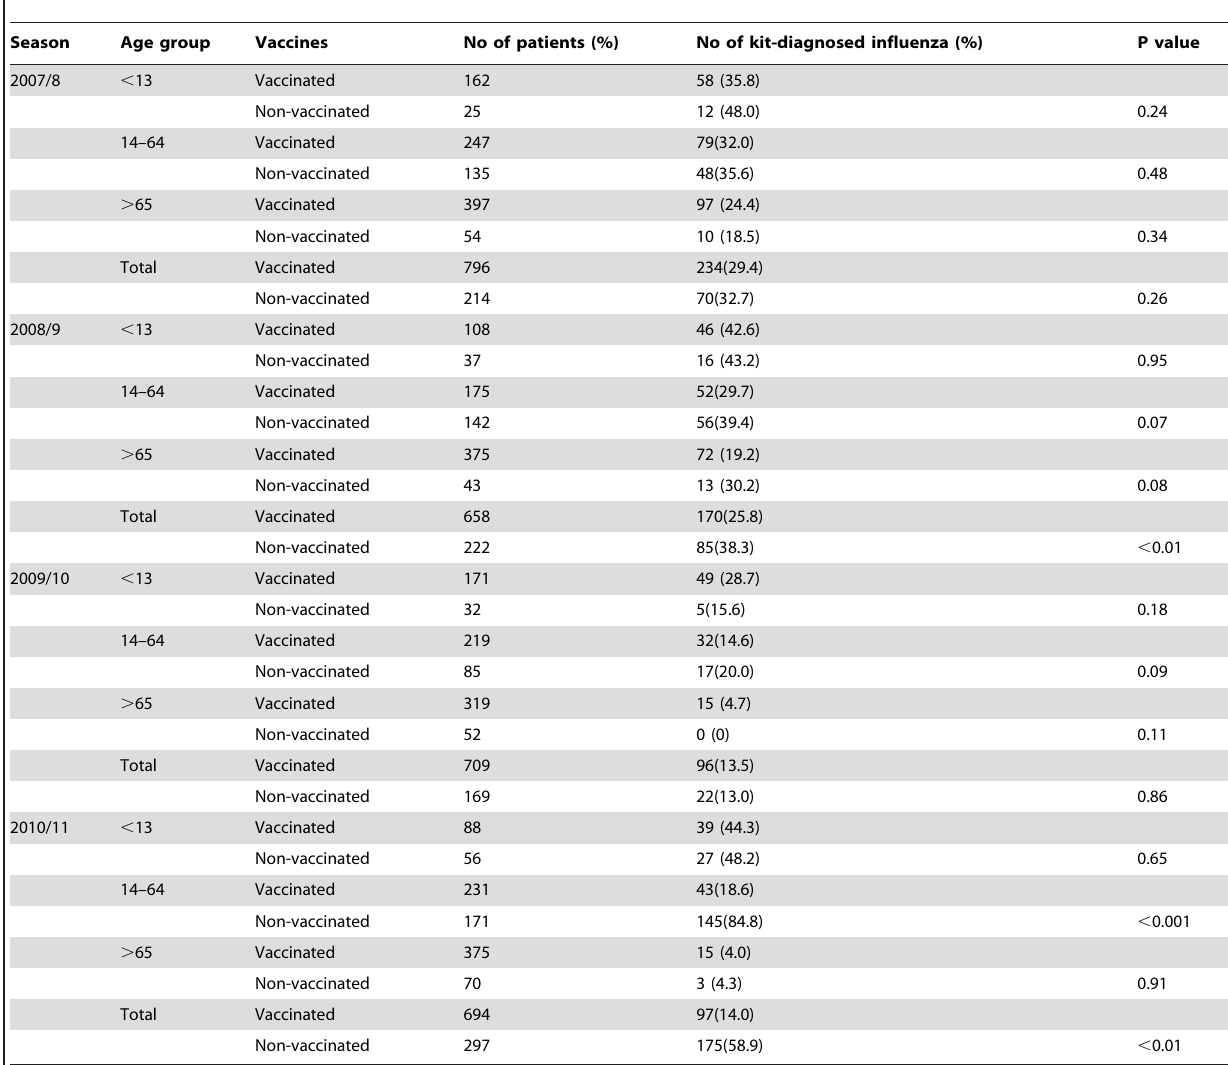
Table 3. Seasonal characteristics of vaccinated and non-vaccinated patients determined using the kitsince 2007 to 2011.